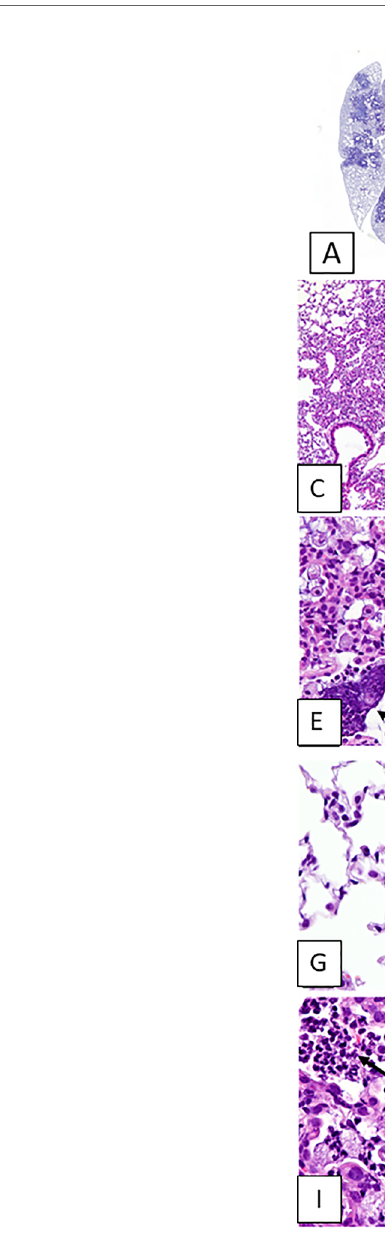
FIGURE 2 | Lung lesions from vitamin-unsupplemented and supplemented in CF mice 5-6 weeks post-parain fl uenza virus infections. Images represent lung tissues sampled 5-6 weeks after an SeV infection. Images in the left column were taken when mice received no vitamin A supplements. Images in the left column represent a mouse that received no vitamin A supplements. Images in the right column represent a mouse that received vitamin A supplements at the time of SeV infections. Panel (A) shows lesions from an unsupplemented mouse. These frequently extended from terminal airways to the lung margins and coalesced with lesions surrounding other bronchioles to involve entire lung lobes (arrows). (C) Lesions were characterized by indistinct borders and alveoli fi lled with debris and cellular in fi ltrates. (E) Cell in fi ltrates consisted mostly of large (activated) alveolar macrophages, with scattered clusters of neutrophils, both intact and degenerating (arrow). Panel (B) shows Pulmonary lesions from a mouse taken 5-6 weeks after an SeV infection with vitamin A supplementation. Lesions were small and sharply demarcated, rarely reaching the lung margin and not affecting entire lung lobes. (D) At higher magni fi cation, lesions were observed with generally clear alveolar spaces, sharply demarcated from surrounding normal parenchyma. Peribronchiolar lymphoid aggregates were also evident (arrow). (F) Septal thickening in the lesioned area was due to interstitial in fl ammatory cell in fi ltrates (lymphocytic) and diffuse hypertrophy of alveolar epithelium. (G, H) Images include areas of normal tissue for comparison to areas of diseased tissue. Images were from unsupplemented and supplemented mice, respectively. (I, J) Images show lesioned areas at 60X magni fi cation in unsupplemented and supplemented mice, respectively. (I) a virus-damaged area in which alveoli were fi lled with clusters of neutrophils (arrows) and large foamy alveolar macrophages (alveolar in fl ammation). (J) Pulmonary lesions were characterized by air- fi lled alveoli with septa thickened by hypertrophic alveolar epithelium and interstitial lymphocytic in fi ltrates (interstitial in fl ammation). Lymphocytic in fi ltrates were prominent surrounding blood vessels (near asterisk). Open alveolar spaces contained normal-sized alveolar macrophages with relatively small amounts of cytoplasm (arrow). Scale bars: B = 1 mm; D = 200 m m; F, G = 100 m